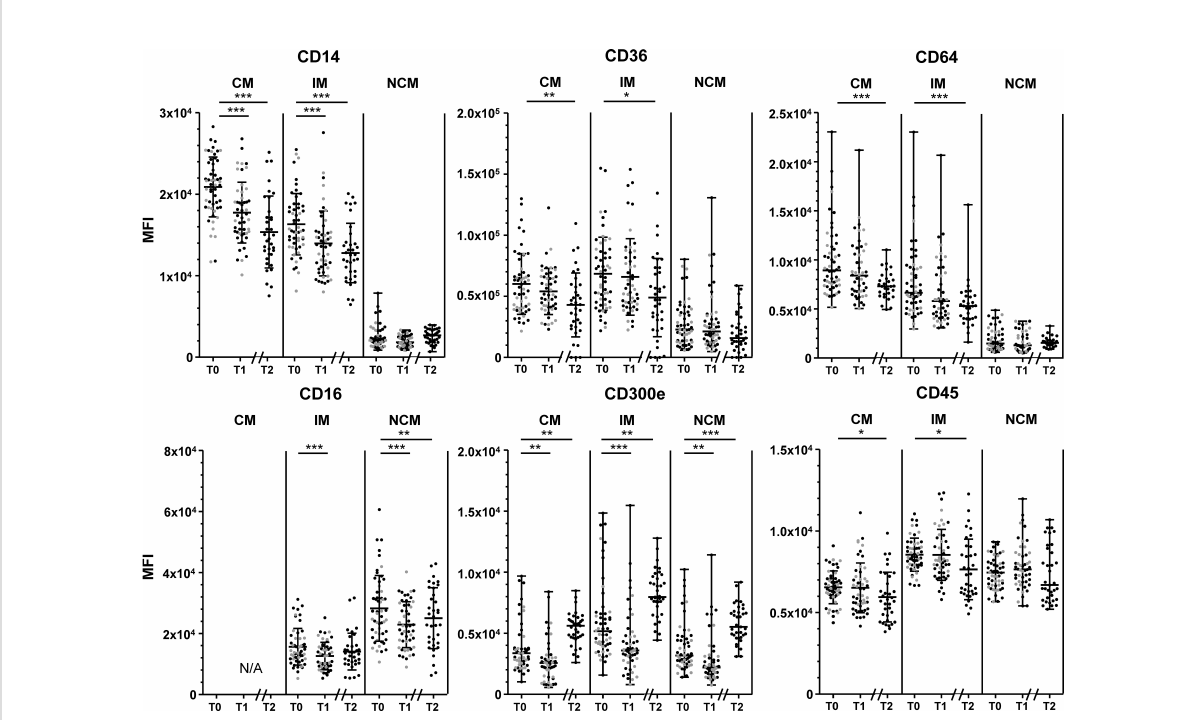
FIGURE 2 Changes in marker expression during the lifestyle intervention. Changes in CD14 expression (upper left), CD36 (upper middle) CD64 expression (upper right), CD16 (lower left), CD300e (lower middle) and CD45 (lower right), in classical monocytes (CM), intermediate monocytes (IM) and non-classical monocytes (NCM) between T0 and T1 of patients who had a complete follow-up at 10 weeks (T1, n=51) and at 1.5 years (T2, n=35). Individuals who had follow-up until T1 are represented as grey dots, individuals with follow-up until T2 are represented as black dots. CD14 expression by CM and IM, CD36 expression by CM and IM, CD16 expression by all subsets, and CD45 expression by CM and IM are normally distributed and are presented as mean + SD. CD300e and CD64 expression by all subsets, CD14 expression, CD36 expression and CD45 by NCM are presented as median + range. Paired T-tests were used to determine the differences between T0 and T1, and between T0 and T2 for normally distributed data, the Wilcoxon signed ranks test for non-normally distributed data. Differences between T0 and T1 were calculated in n=51 participants, differences between T1-T2 and T0-T2 were calculated in n=35 participants. N/A: not applicable. MFI: median fl uorescence intensity. *p < 0.05, **p < 0.01, ***p <